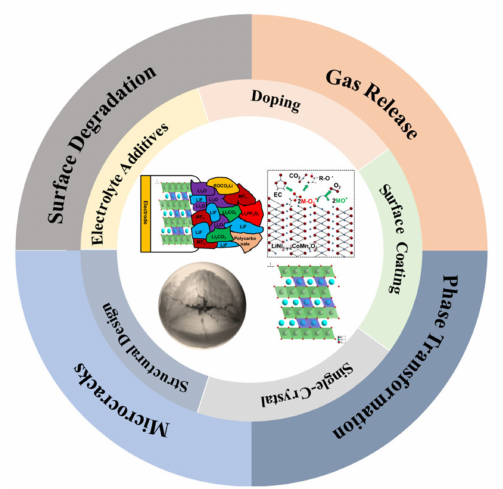
Figure 1. Challenges and modification strategies of Ni-rich cathode materials under high